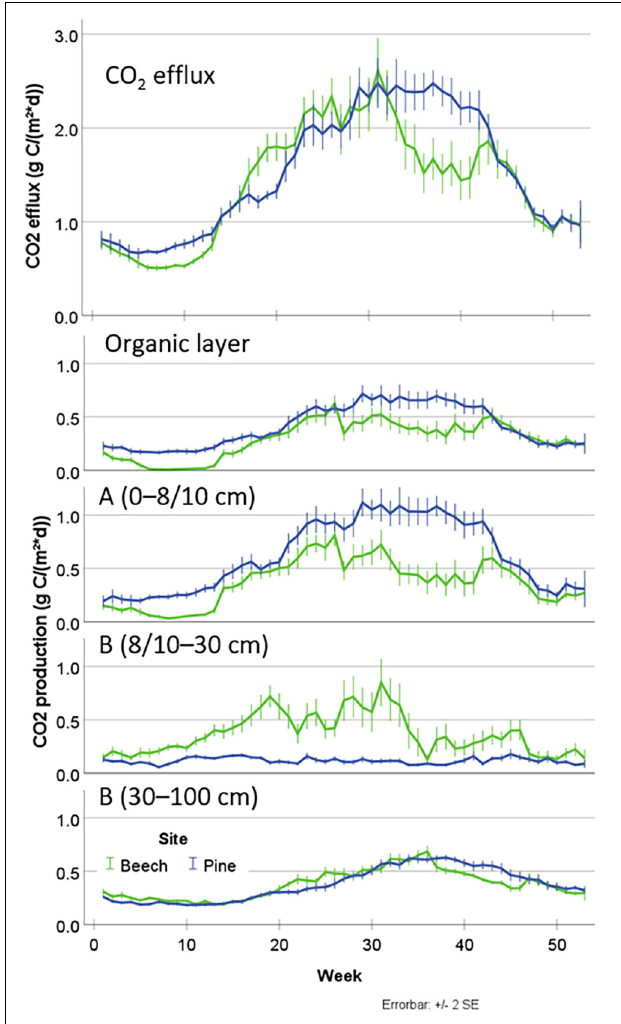
FIGURE 5 | Seasonal dynamics of CO 2 efflux (upper graph) and layer-related CO 2 production (lower graphs) with mean values and error bars ± 2 standard error units (SE) from the beech site and the pine site as weekly means over the years